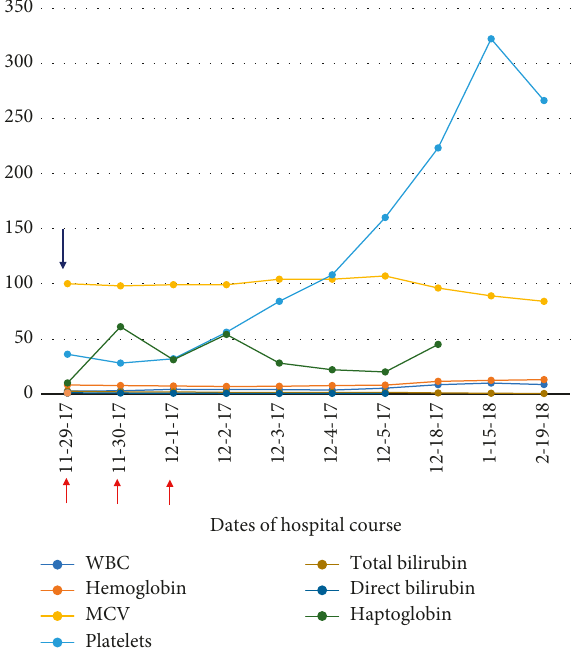
Figure 2: Significant lab values throughout hospital course and three months after initial therapy. Red arrows indicate the dates in which the patient underwent plasmapheresis. The blue arrow in- dicates the date in which B12 replacement was